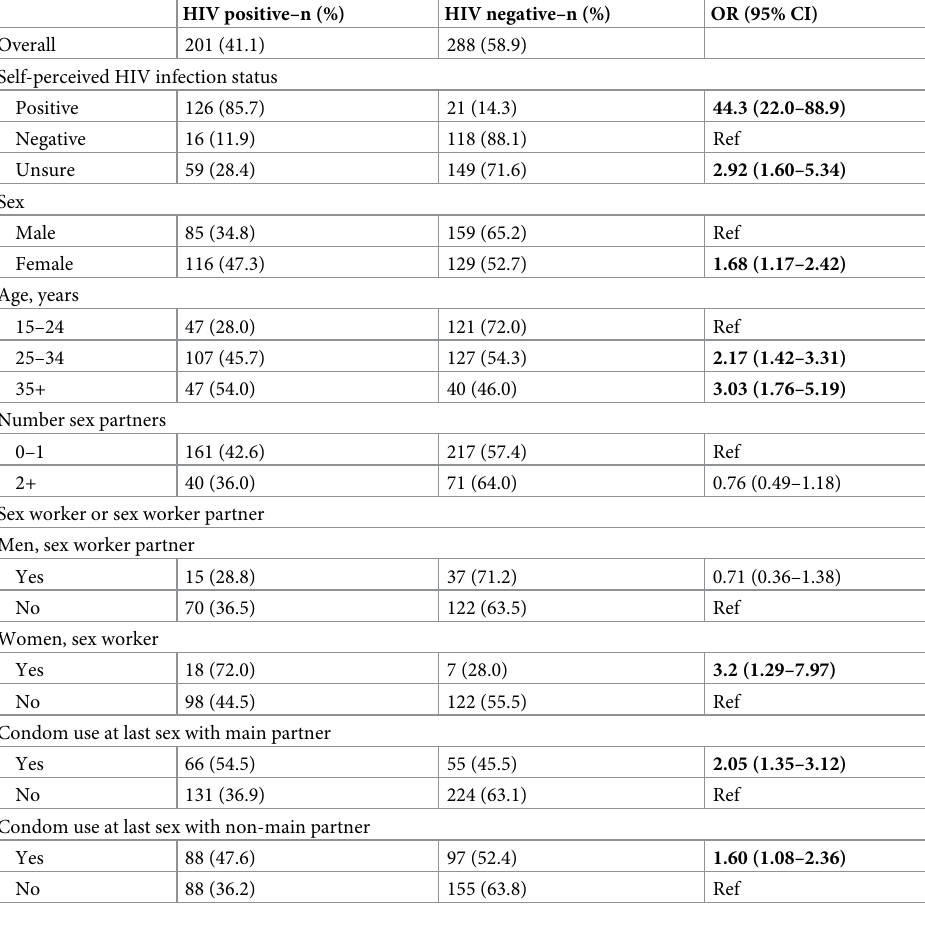
Table 1. Demographic characteristic and risk behavior associations with prevalence of HIV-1 infection in sexually transmitted infection clinic patients, Zimbabwe– 2014–2015. HIV positive–n (%) HIV negative–n (%) OR (95%